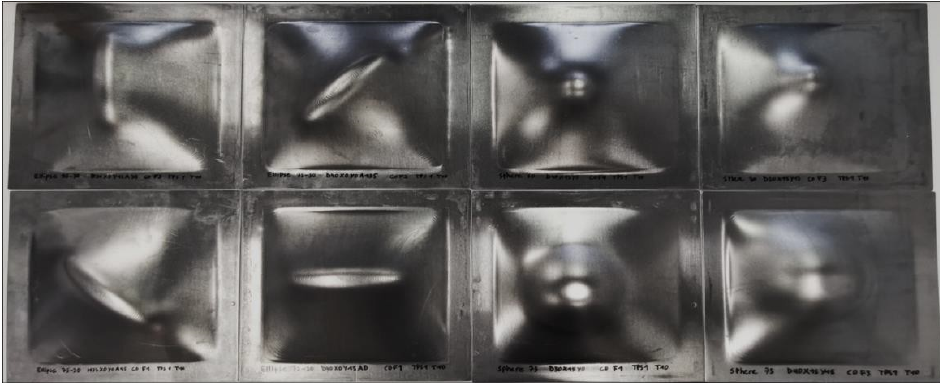
Figure 2. 8 Ellipsoid training geometries determined using the fractional factorial method 2 III 6−3 . Table 3. Ellipsoid training and test set workpiece parameters.